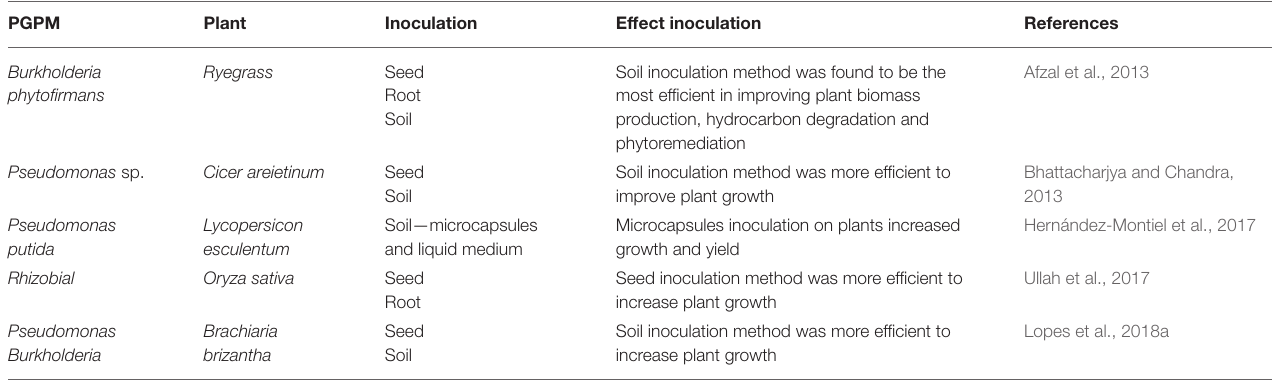
TABLE 1 | Effect inoculation methods on plant growth-promoting microbes (PGPM) potential